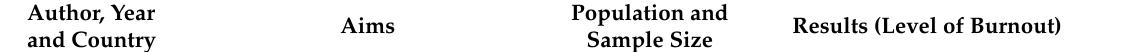
Table 2. Summary of articles’